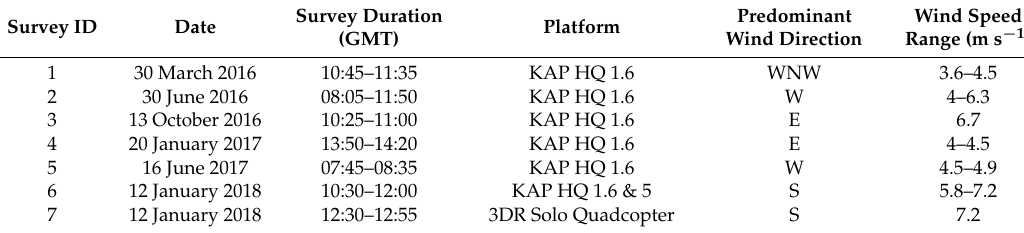
Table 1. Details of each KAP and drone survey undertaken and associated wind conditions. Times (in GMT) are estimations based on the first and last photos that are deemed useable in the photogrammetry workflow. Wind data from Camborne weather station (located approximately 4.7 km ESE from the study system (Figure 1B)). Weather data obtained from Met Office DataPoint Service (https://www.metoffice.gov.uk/datapoint; contains public sector information licensed under the